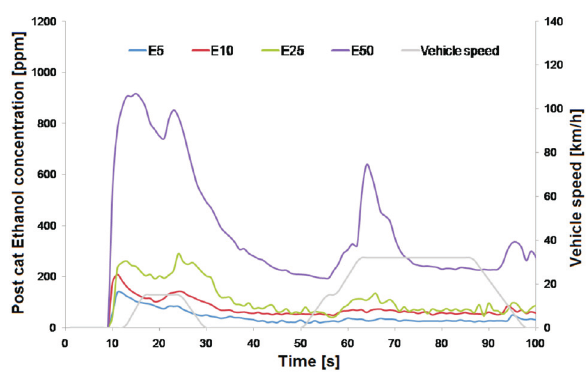
Fig. 11. Pre cat ethanol concentrations for various blends over the first 100 seconds of the NEDC (source: BOSMAL data – see [9] for com -